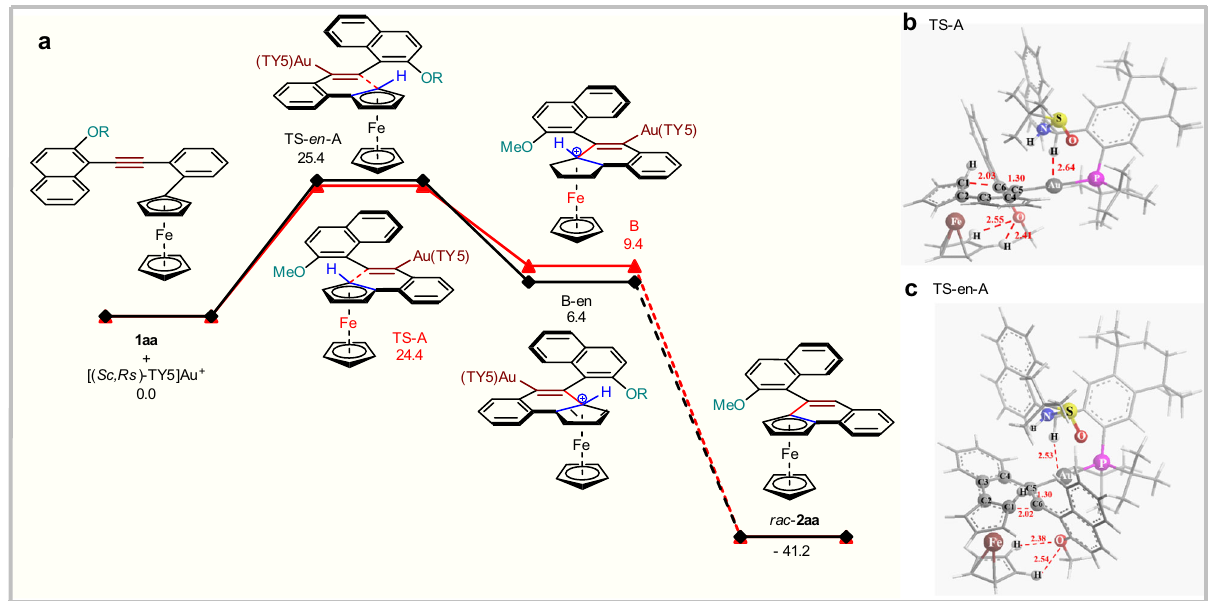
Fig. 5 Density functional theory (DFT) calculations. a The Free-energy reaction pro fi les (kcal mol − 1 ) for the reaction of 1aa , calculated with SMD Model (dichloromethane) using M062X at 273 K. b and c The optimized transition states TS-A, TS-en-A for the enantioselectivity-determining step, calculated with SMD Model (Dichloromethane) with M062X method at 273